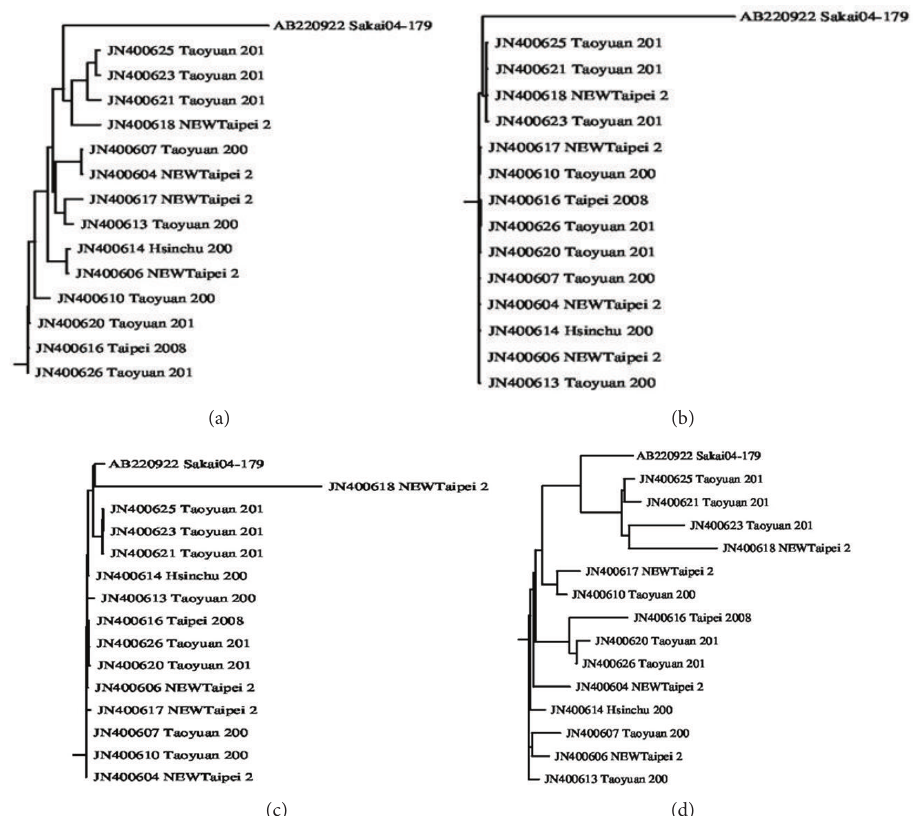
Figure 10: Phylogenetic trees for full length and different ORF regions: (a) full length, (b) ORF1, (c) ORF2, and (d) ORF3.